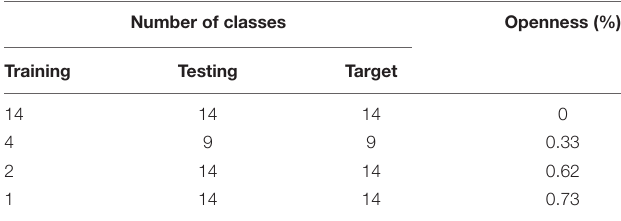
TABLE 2 | Calculation of the openness level for domain adaptation based on Eq.